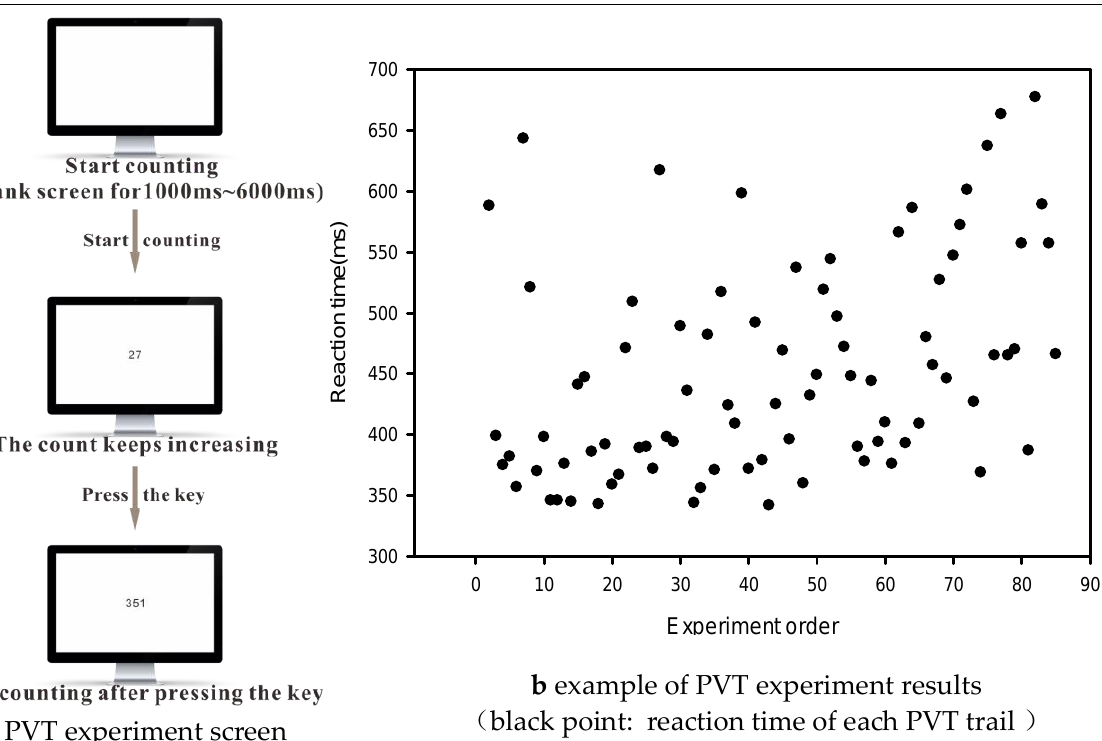
Figure 2. Psychomotor vigilance task